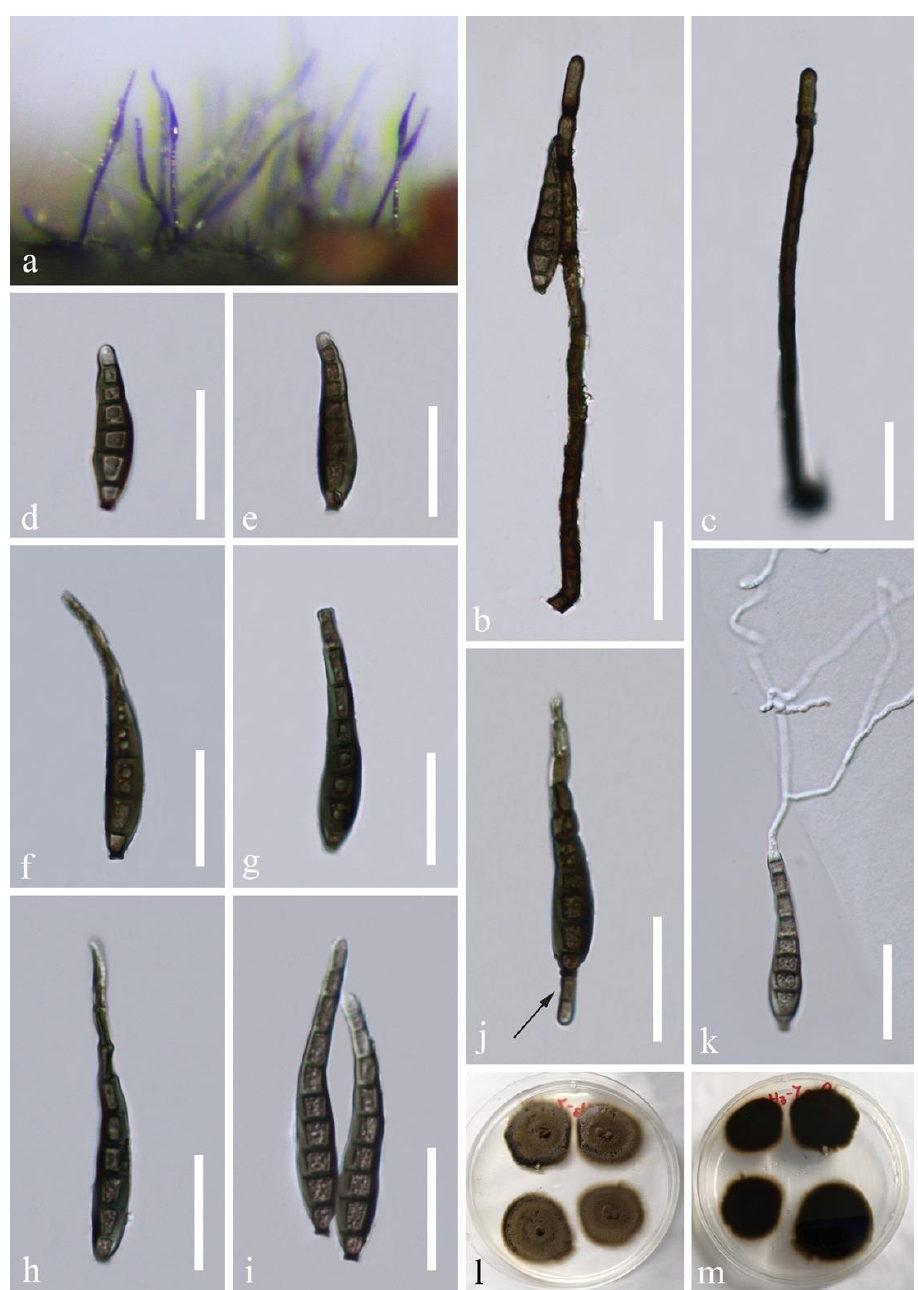
Figure 4. Distoseptispora effusa (GZAAS 20-0427, holotype). ( a ) Colonies on natural substrate. ( b , c ) Conidiophores. ( d – i ) Conidia. ( j ) Conidiogenous cell with a conidium. ( k ) Germinated conidium. ( l , m ) Culture, l from above, m from below. Scale bars: ( b – k ) 50 μ m. Cultural characteristics: conidia germinated on WA within 24 h and germ tube pro- duced from the apex. Colonies on PDA reaching 15–20 mm diam. after 2 weeks at 25 ◦ C in dark, circular, with fluffy, dense, dark olivaceous brown aerial mycelium on the surface; in reverse dark brown with entire